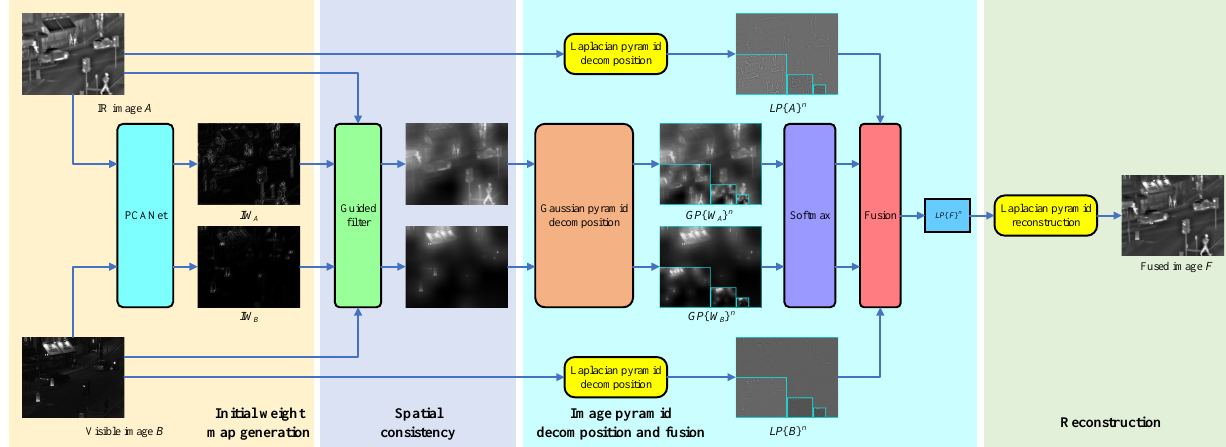
Figure 1. Schematic diagram of the proposed